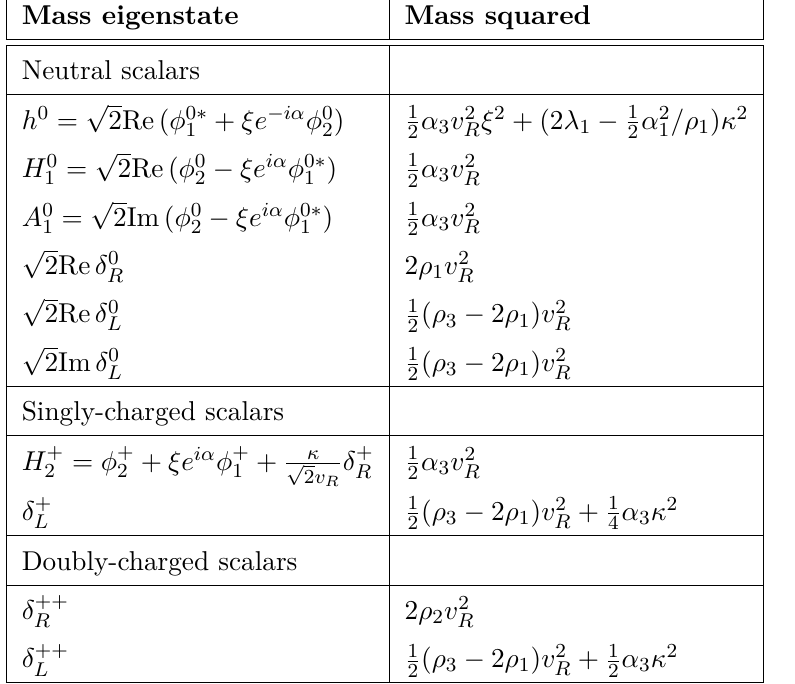
Table 4 . The physical Higgs mass eigenstates and their masses for the P -symmetric potential, restricted to the β = v = 0 case. Only linear terms in κ/v i L 183]. The definitions of the parameters from the Higgs potential can be found in